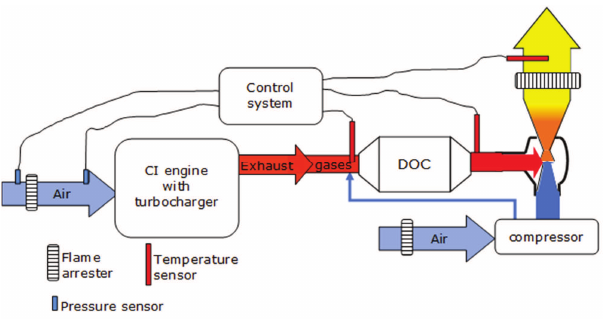
Fig. 8. Design concept of air cooling of exhaust gases with DOC reactor